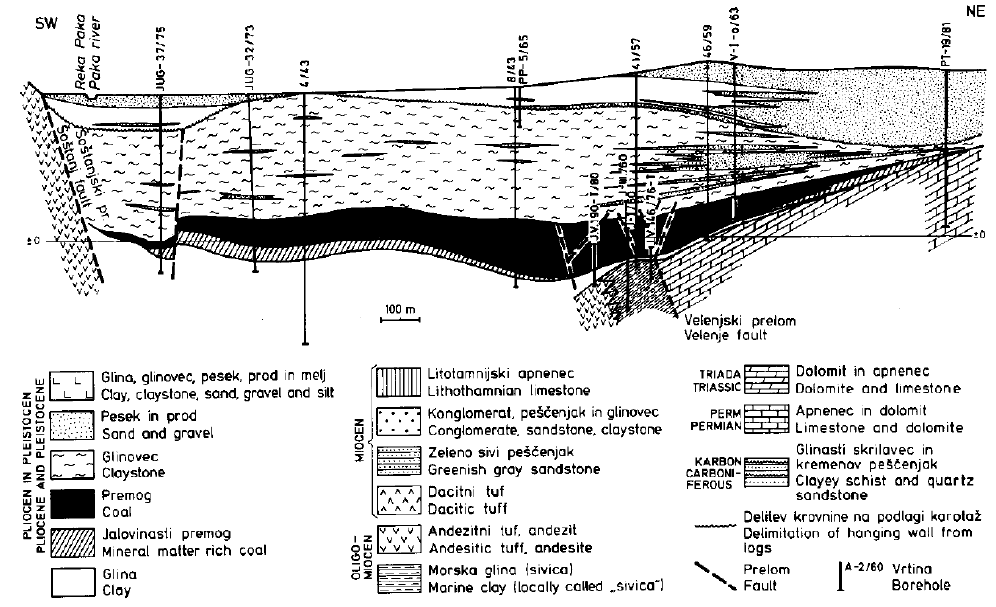
Figure 2. Geological profile SW ‐ NE of the VCM coal ‐ bearing depression [3].